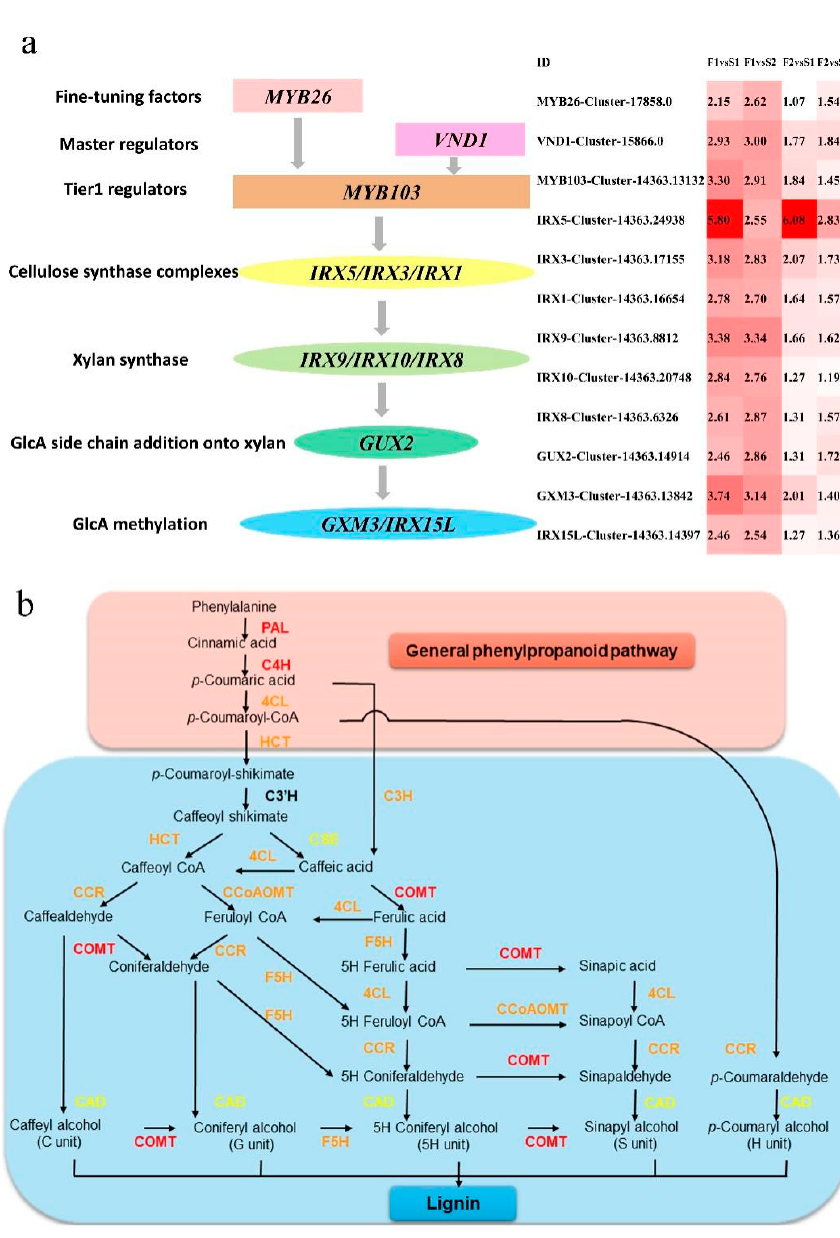
Figure 6. ( a ) Illustration of the predicted transcriptional regulating and secondary walls synthesis genes of branch growth in elm. The expression levels (Log2(FC)) of selected differentially expressed genes in fast- and slow-growing cultivars are shown on the right. A red color indicates that the gene is highly expressed in the branch samples. Log2(FC) means Log2() value of fold change for unigenes. ( b ) The biosynthesis pathway of the general phenylpropanoid and lignin. PAL, phenylalanine ammonia-lyase; TAL, tyrosine ammonia-lyase; C4H, cinnamate 4-hydroxylase; 4CL, 4-coumarate: CoA ligase; CCR, cinnamoyl-CoA reductase; HCT, hydroxycinnamoyl-CoA shikimate/Quinatehydroxycinnamoyltransferase; CCoAOMT, caffeoyl-CoA O-methyltransferase; F5H, ferulate 5-hydroxylase; CSE, caffeoyl shikimate esterase; COMT, caffeic acid O-methyltransferase; CAD, cinnamyl alcohol dehydrogenase. The color of the proteins indicates the expression of their coding genes in fast and slow growing branches: red indicates up-regulated in the four comparisons (F1vS1, F1vS2, F2vS1, F2vS2), orange indicates up-regulated in three comparisons, yellow indicates up-regulated in two